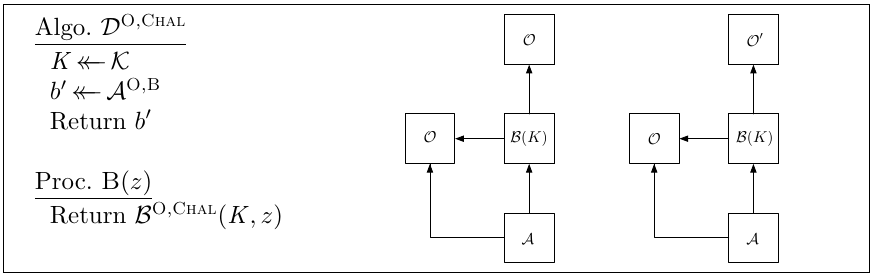
Figure 6: Two-stage adversaries and their operation in the split